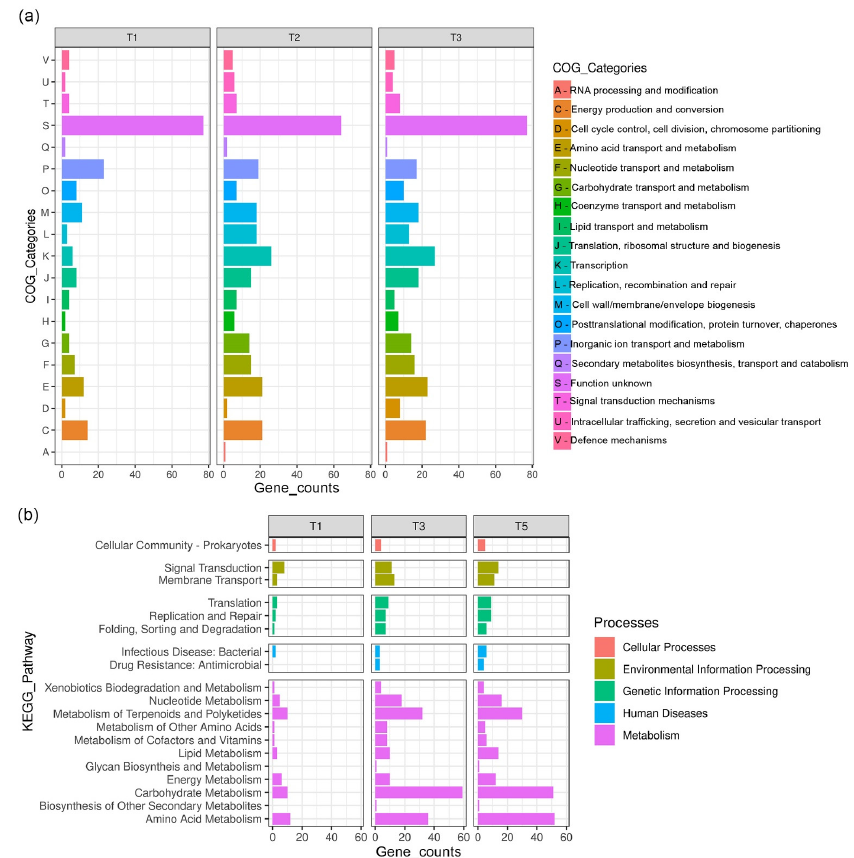
Figure 6. DEGs enrichment analyses based on ( a ) Clusters of Orthologous Groups and ( b ) Kyoto Encyclopedia of Genes and Genomes.